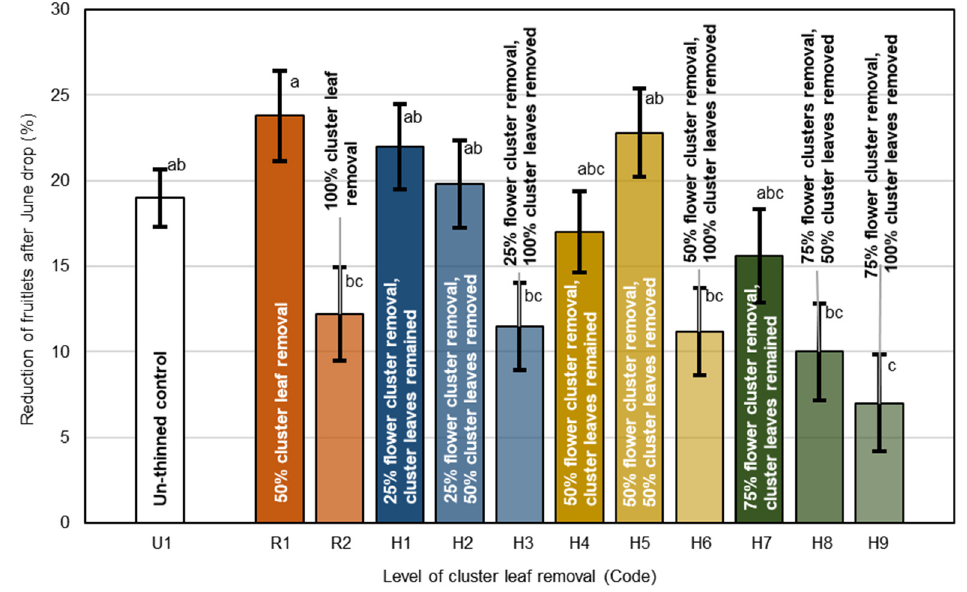
Figure 8. Effect of source-sink modification such as cluster leaf and flower cluster removal on reduction of fruitlets in June drop expressed as difference of the number of fruitlets before and after June drop (color coding and explanations as for Figure 4). Table 3. Effect of thinning treatment on the maturity of harvest of apple cv. ‘Roter Boskoop’ in 2018 and blossom intensity in